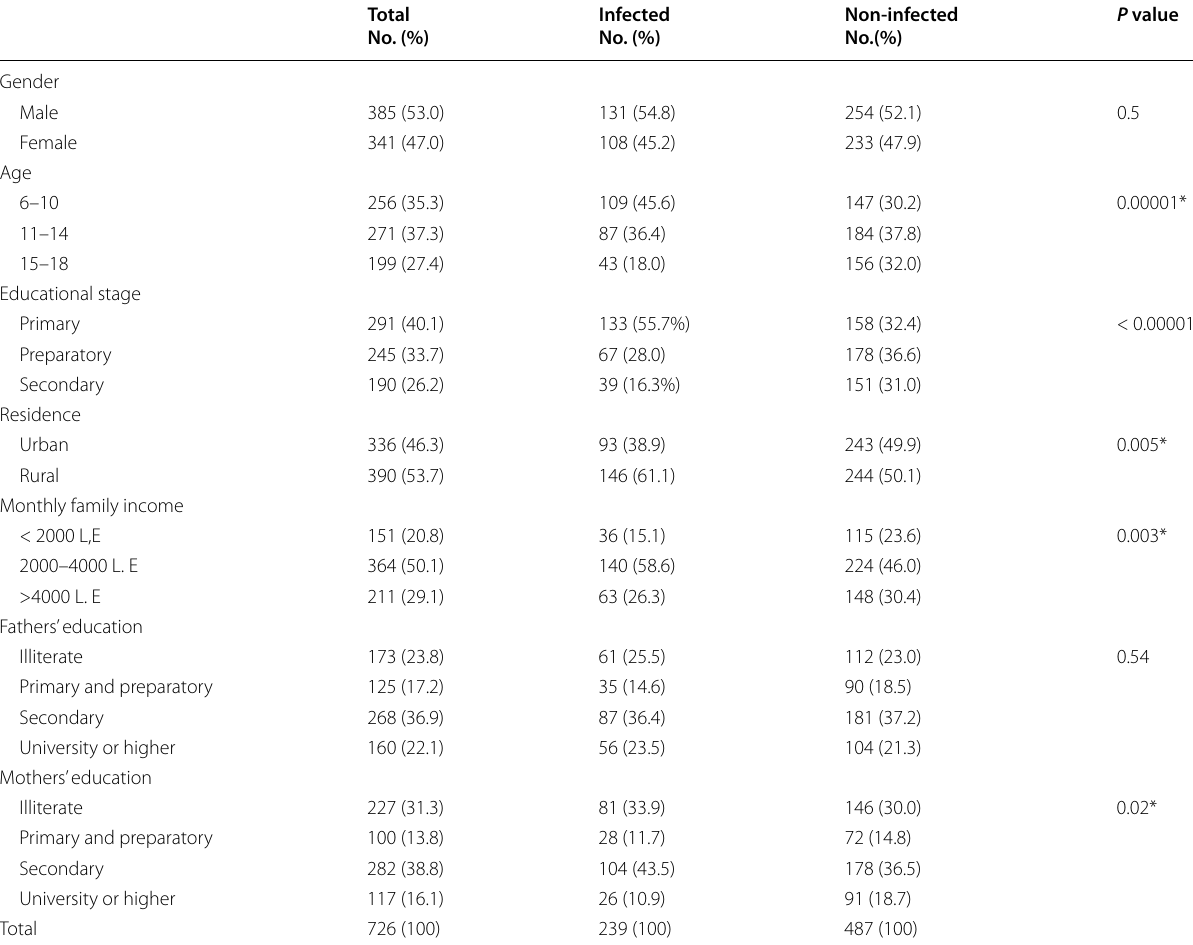
Table 2 Socio‑demographic risk factors of parasitic infection among studied school